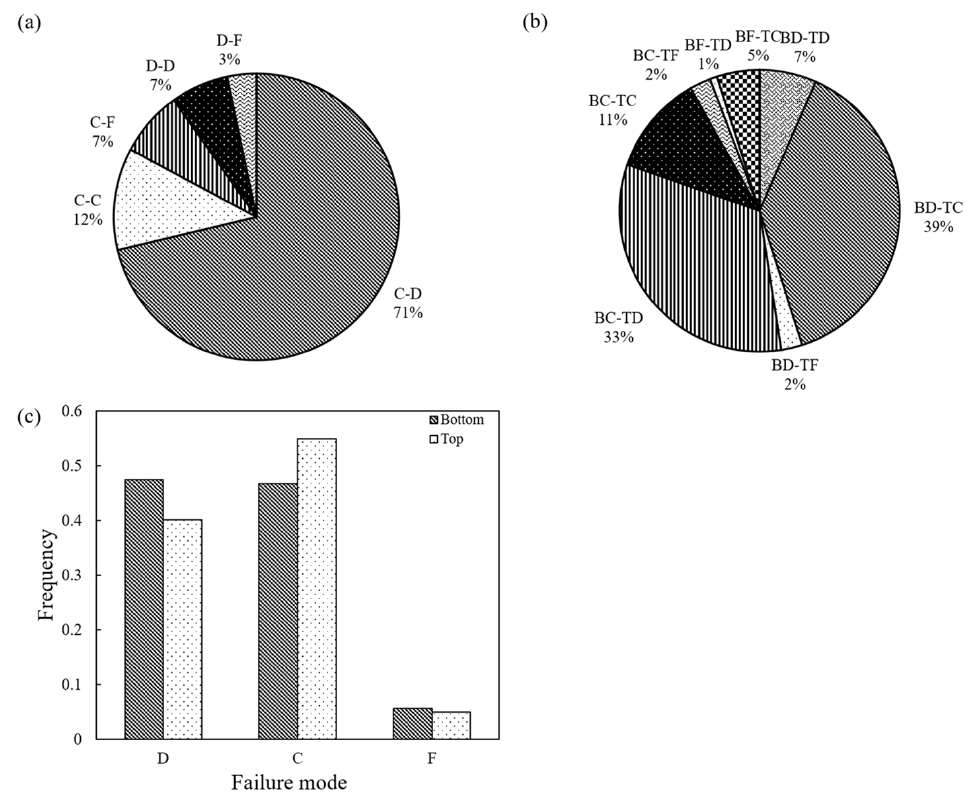
Figure 16. Failure pattern for loading rate 1 mm/min: ( a ) system failure mode; ( b ) system failure mode when considering particle position; ( c ) failure mode for top and bottom grains.